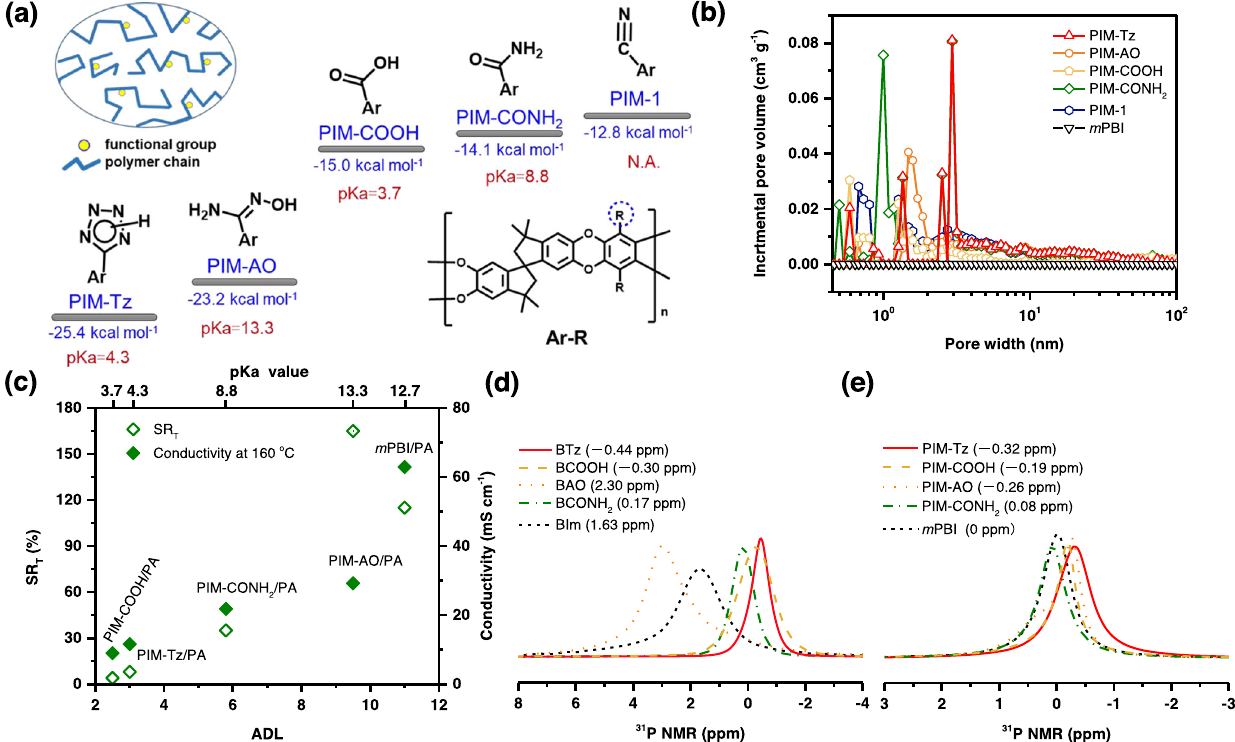
Fig.2|PropertiesofthefunctionalPIMs.a Structures,p K a valuesandphosphoric acid binding energies ofPIMs and its variants; b incrementalporevolumes of PIMs and PBI as a function of the pore size measured from N 2 adsorption/desorption isotherms. c CharacteristicsofPA doped fi lms of the functionalizedPIMs aswellas PBIincludingtheaciddopinglevel(ADL)andthicknessswellingratio(SR T )atroom